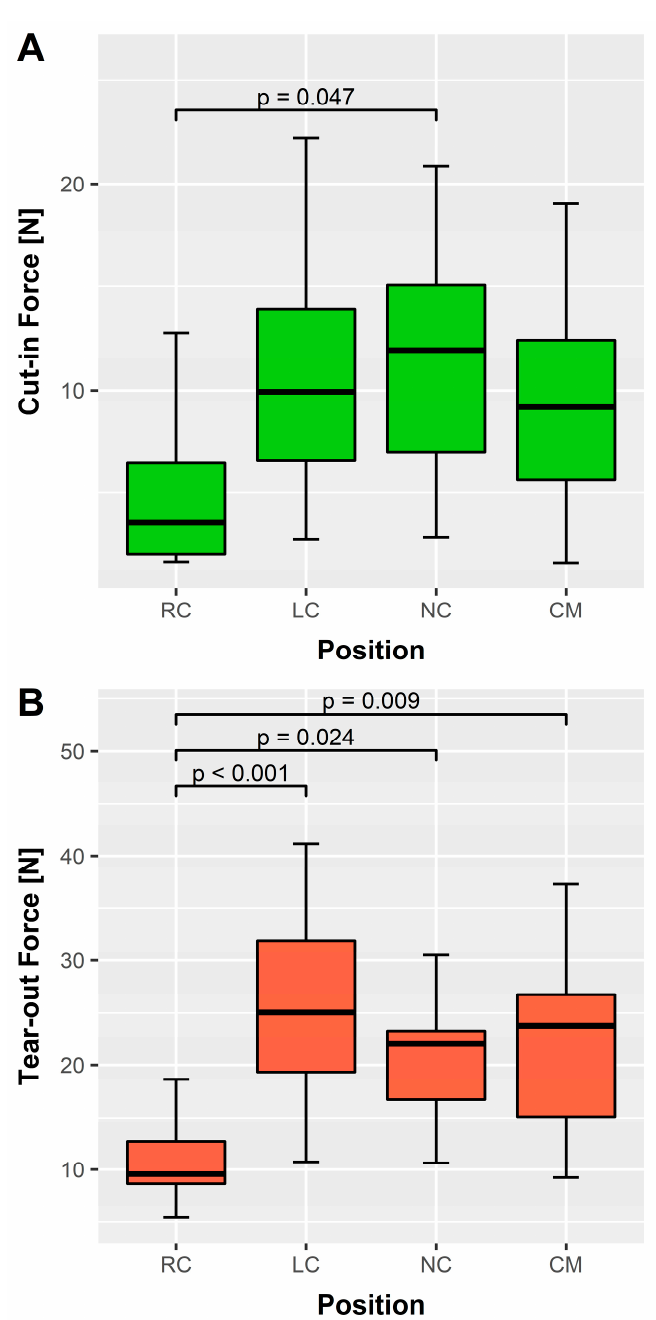
Figure 4. Boxplots showing the threshold forces in relation to the suture position. ( A ) Cut-in forces (green); ( B ) Tear-out forces (red). The right coronary position shows the lowest forces necessary to cause damage. Additionally, indicated are the significant differences (5% level) according to Tukey’s post-hoc test, including their p values. CM, commissure; LC, left coronary; NC, noncoronary; RC, right coronary.